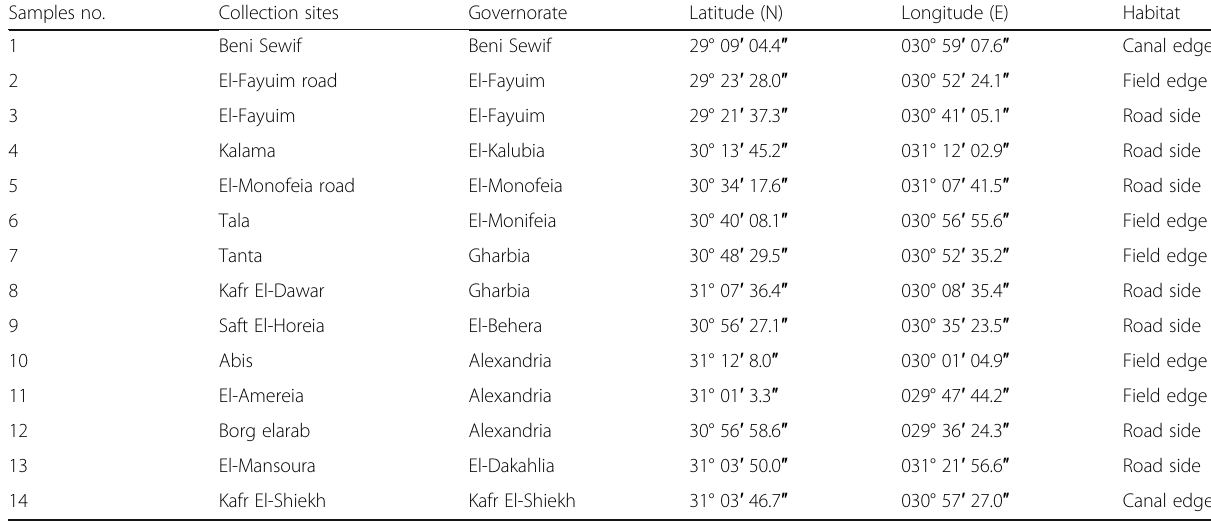
Table 1 GPS of the sites of Silybum marianum studied samples Samples